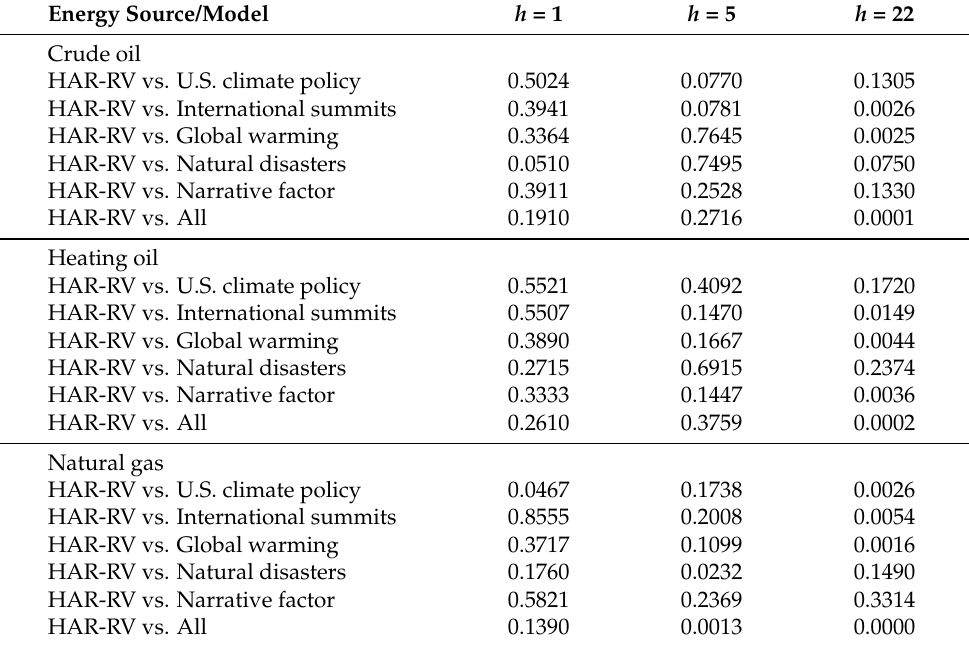
√ RV . Results ( p -values; robust heteroskedasticity and autocorrelation Table 3. Test results for consistent standard errors) of the Clark–West tests for an equal mean-squared prediction error are based on robust standard errors. The classic HAR-RV model is the benchmark model, and the model extended to include climate-risk factors is the rival model. The alternative hypothesis is that the rival model has a smaller MSPE than the benchmark model. The parameter h denotes the forecast horizon (in days). The models are estimated using a rolling-estimation window of length 250